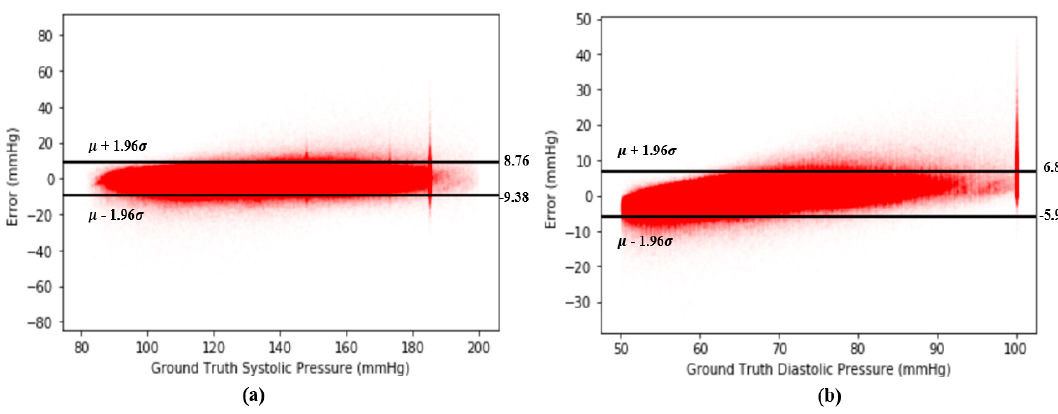
Figure 13. ( a ) Bland–Altman plot for error of SBP across 2,176,188 records and ( b ) Bland–Altman plot for error of DBP across 2,176,188 records.